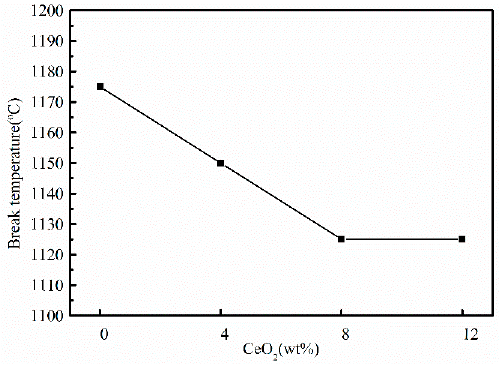
Figure 5. The break temperature of experimental mold fluxes with different CeO 2 contents.